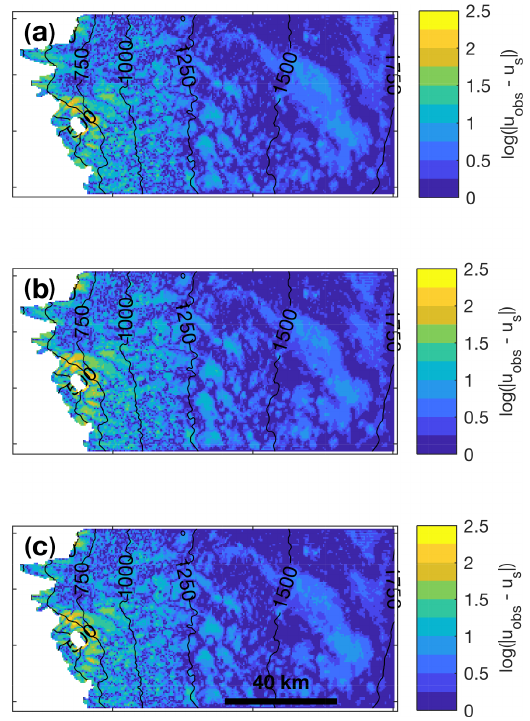
Figure 4. Map of the log of the absolute difference between the ob- served and modelled surface velocities for inversions using (a) Lin- ear sliding law, (b) Budd sliding law, and (c) Schoof sliding